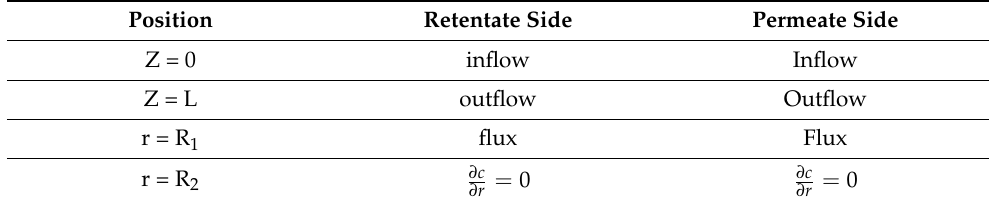
Table 1. Boundary condition at retentate and permeate